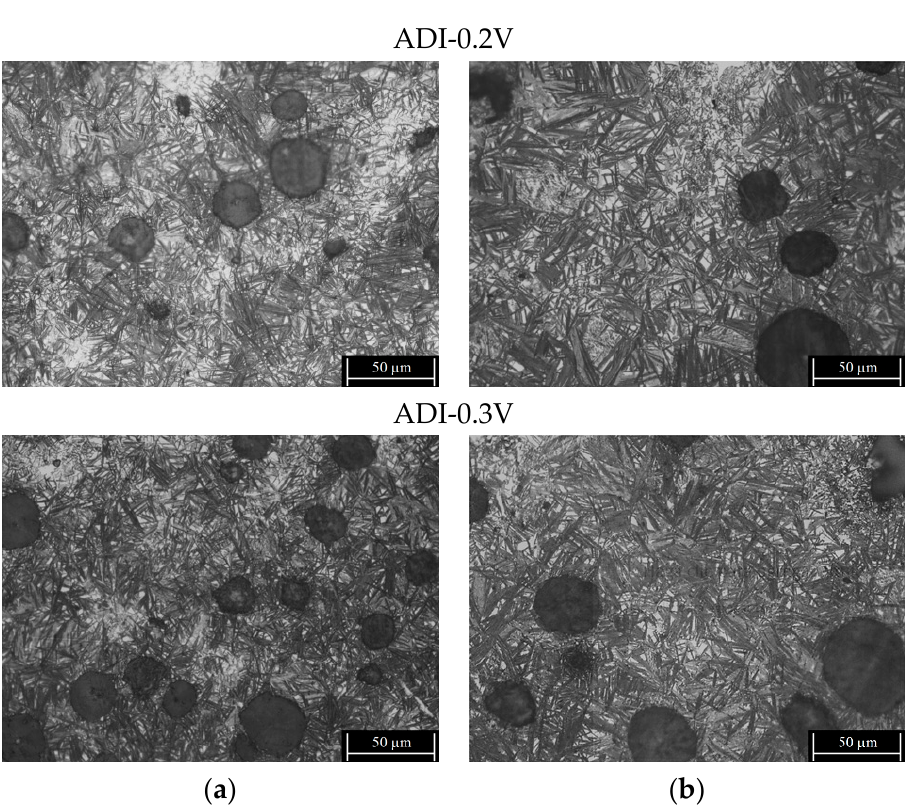
Figure 7. Microstructure of ADI alloyed with 0.2 and 0.3 wt % V heat ‐ treated to ( a ) 265 °C and ( b ) 305 °C for 90 min.